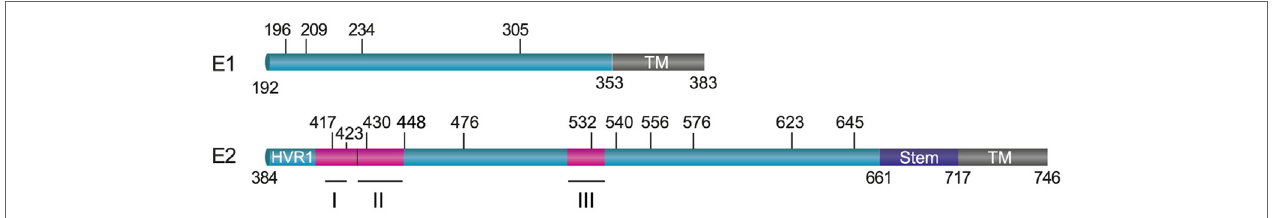
FiGURe 1 | Position of N-linked glycans on hepatitis C virus envelope glycoproteins. E1 and E2 are schematically represented by boxes with their transmembrane domains shown in brown. The glycosylation sites and their position are indicated by vertical bars (on reference strain H77). The localization of three